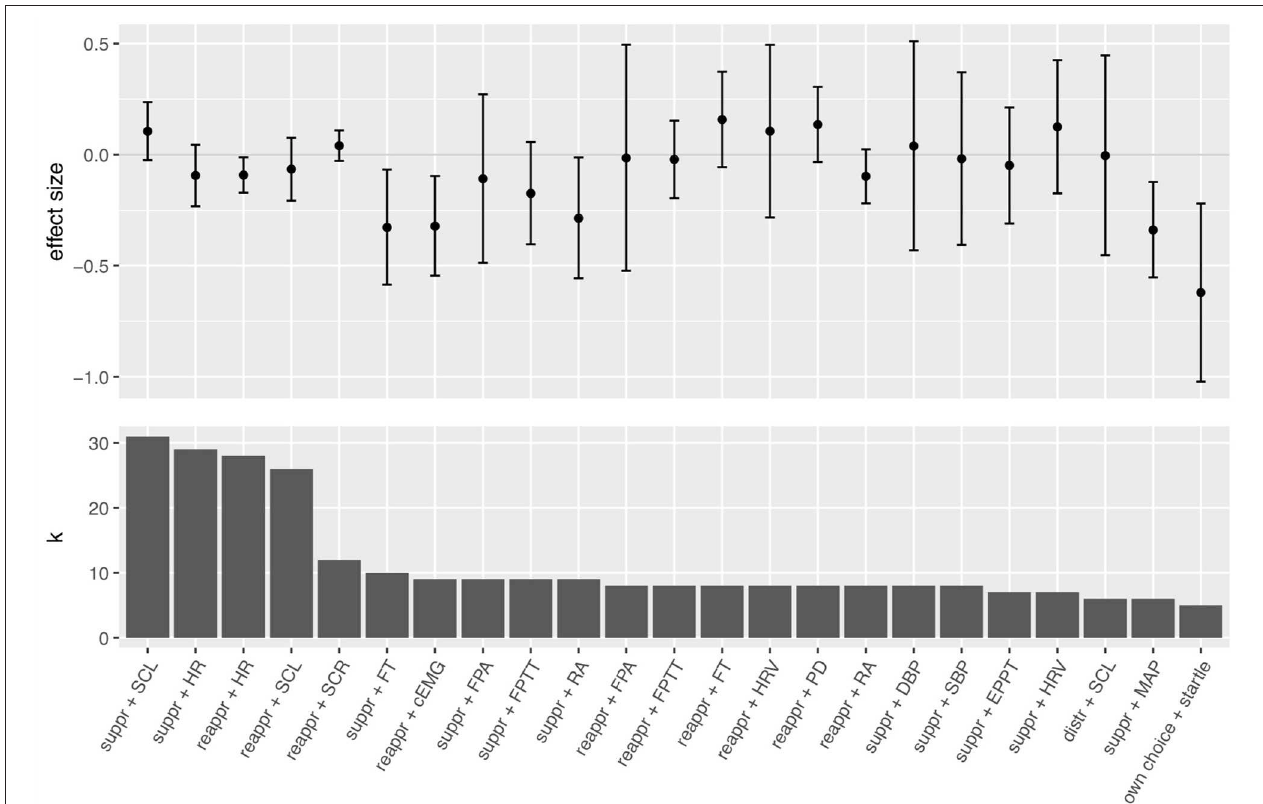
FIGURE 3 | Mean effect sizes and confidence intervals for each conducted meta-analysis (upper panel) sorted by number of samples k of the meta-analysis, respectively (lower panel). Suppr, suppression; reappr, reappraisal; distr, distraction; HR, heart rate; SCL, skin conductance level; SCR, skin conductance response; FT, finger temperature; cEMG, corrugator activity; FPA, finger pulse amplitude; FPTT, finger pulse transit time; RA, respiration amplitude; HRV, heart rate variability; PD, pupil dilation; DBP, diastolic blood pressure; SBP, systolic blood pressure; EPTT, ear pulse transit time; MAP, mean arterial